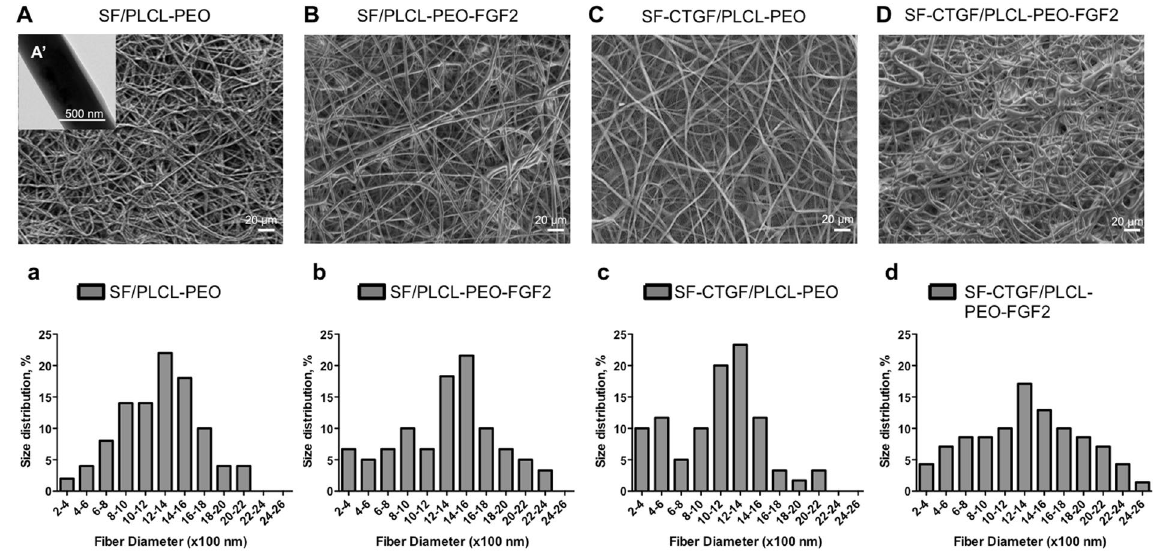
Figure 1. Characterization of coaxial electrospun scaffold. ( A – D ) SEM images of electrospun nanofibrous scaffolds. (A’) TEM image of the SF/PLCL-PEO coaxial fibers. (a–d) Fiber diameter distribution of four groups of scaffolds.